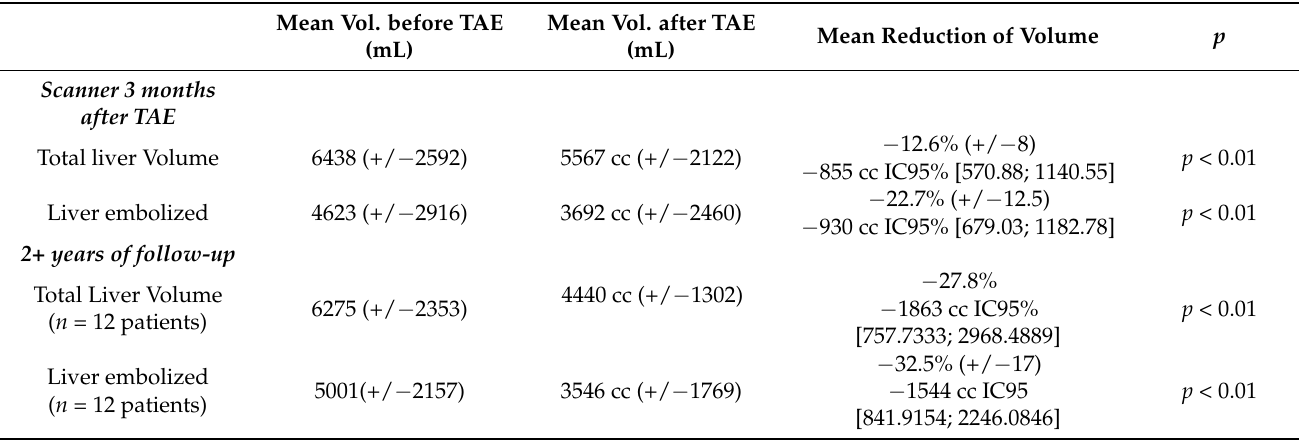
Table 4. Liver volume reduction at 3 months and 2 years after